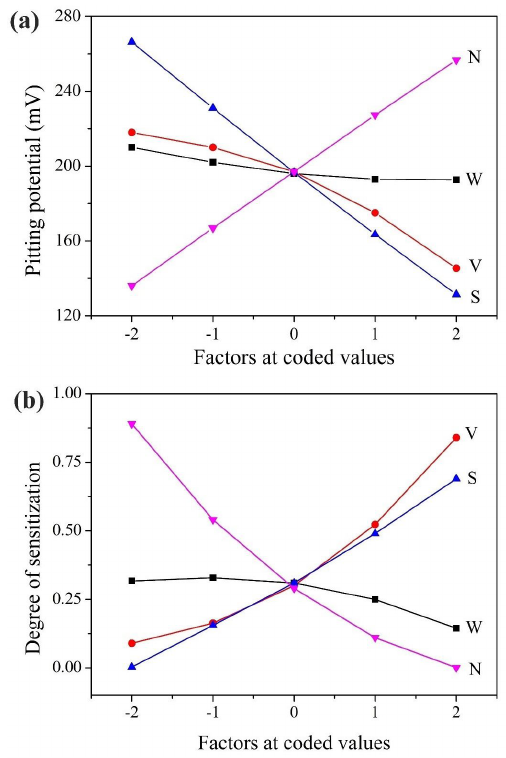
Figure 4. Effect of nozzle to plate distance ( N ), wire feed rate ( W ), welding voltage ( V ) and welding speed ( S ) on: (a) pitting potential and (b) degree of sensitization.